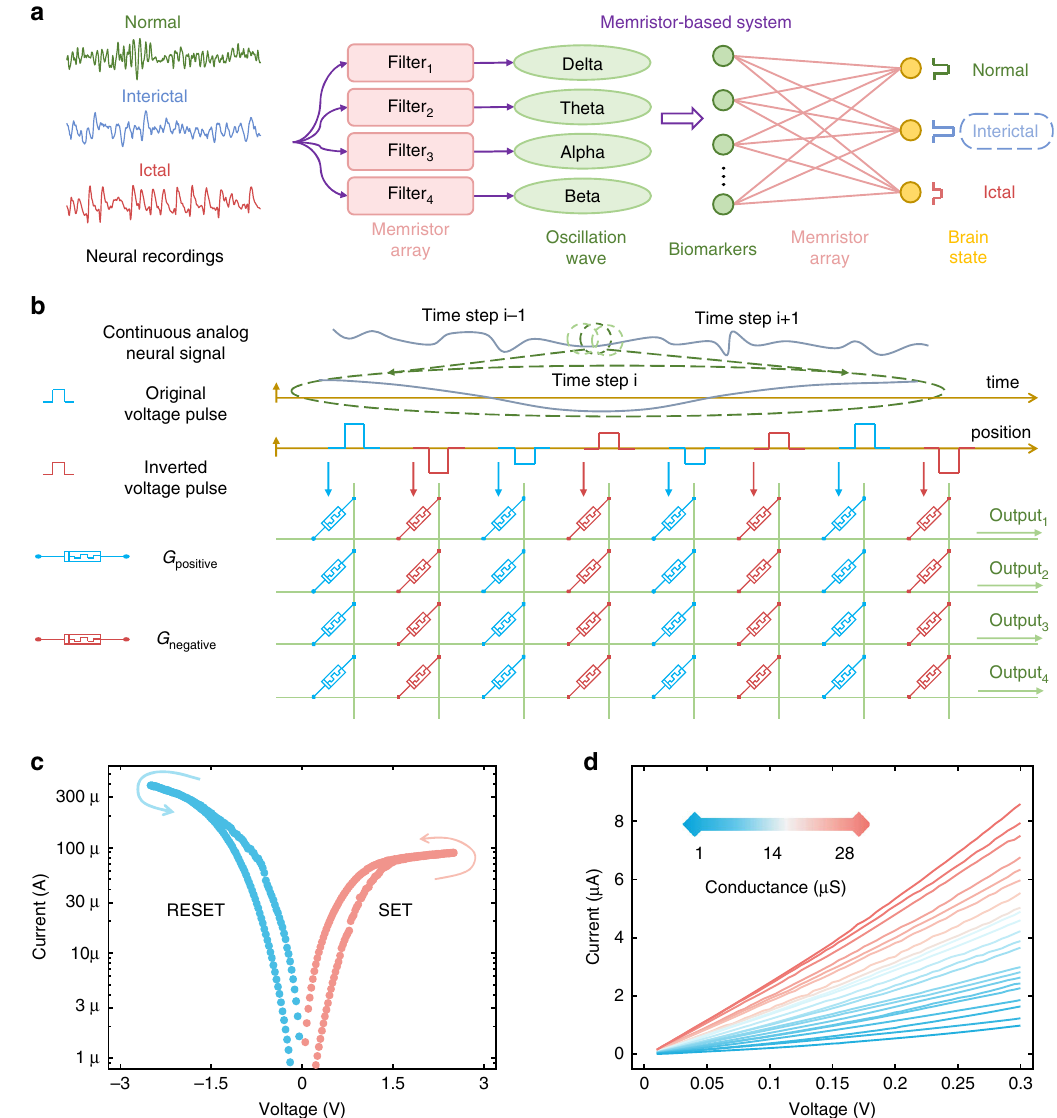
Fig. 2 The implementation of memristor-based neural signal analysis system. a Schematic of the memristor-based system to identify epilepsy-related brain state. Normal, interictal, and ictal neural activities are fi ltered by the memristor array to obtain oscillation waves in δ , θ , α , and β frequency bands. Biomarkers extracted from the fi ltered waves are used to identify the brain state through a single-layer neural network, which is implemented in another memristor array. b Implementation of the fi lter bank for neural activities in a memristor array. Continuous analog neural signal is conditioned and sampled as voltage pulses, which are applied to the input columns of the memristor array. Here G positive and G negative represent the memristor conductances for positive and negative weights, respectively. c A typical d.c. I – V curve for a single memristor, showing excellent analog switching behaviors in both SET and RESET processes. d Current-voltage ( I – V ) characteristics read at different conductance states, showing good I – V linearity. Source data are provided as a Source Data fi